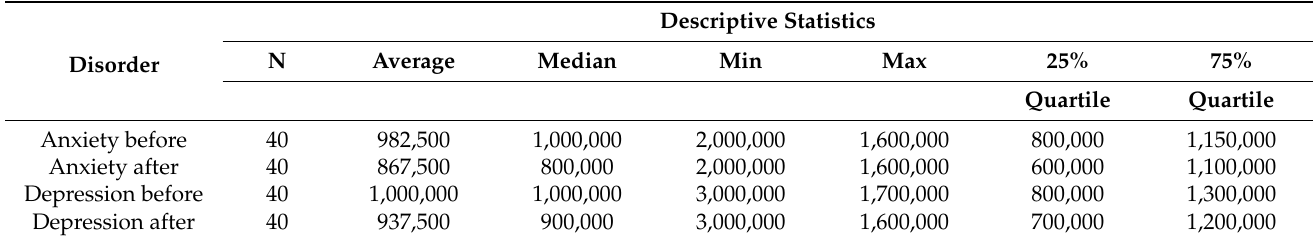
Table 4. Descriptive statistics of HADS before and after the treatments.